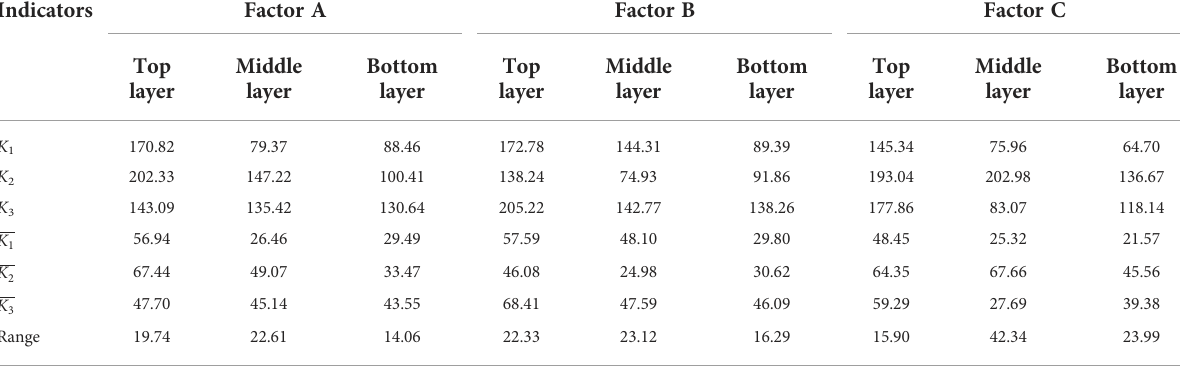
TABLE 7 Canopy vertical longitudinal fog droplet distribution uniformity range analysis. Indicators Factor A Factor B Factor